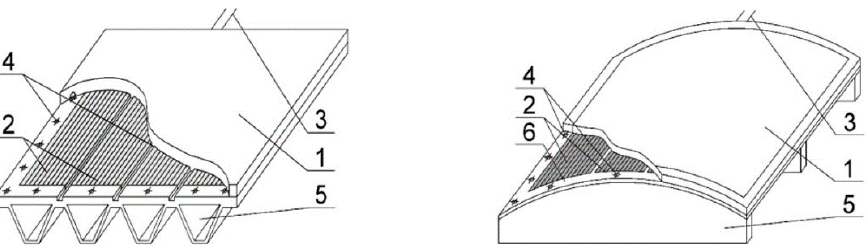
Figure 1. Moulding tool with the resistive layer, 1—shaping surface, 2—resistive blocks, 3—current- carrying wires, 4—mounting position, 5—frame, 6—resistive layer.